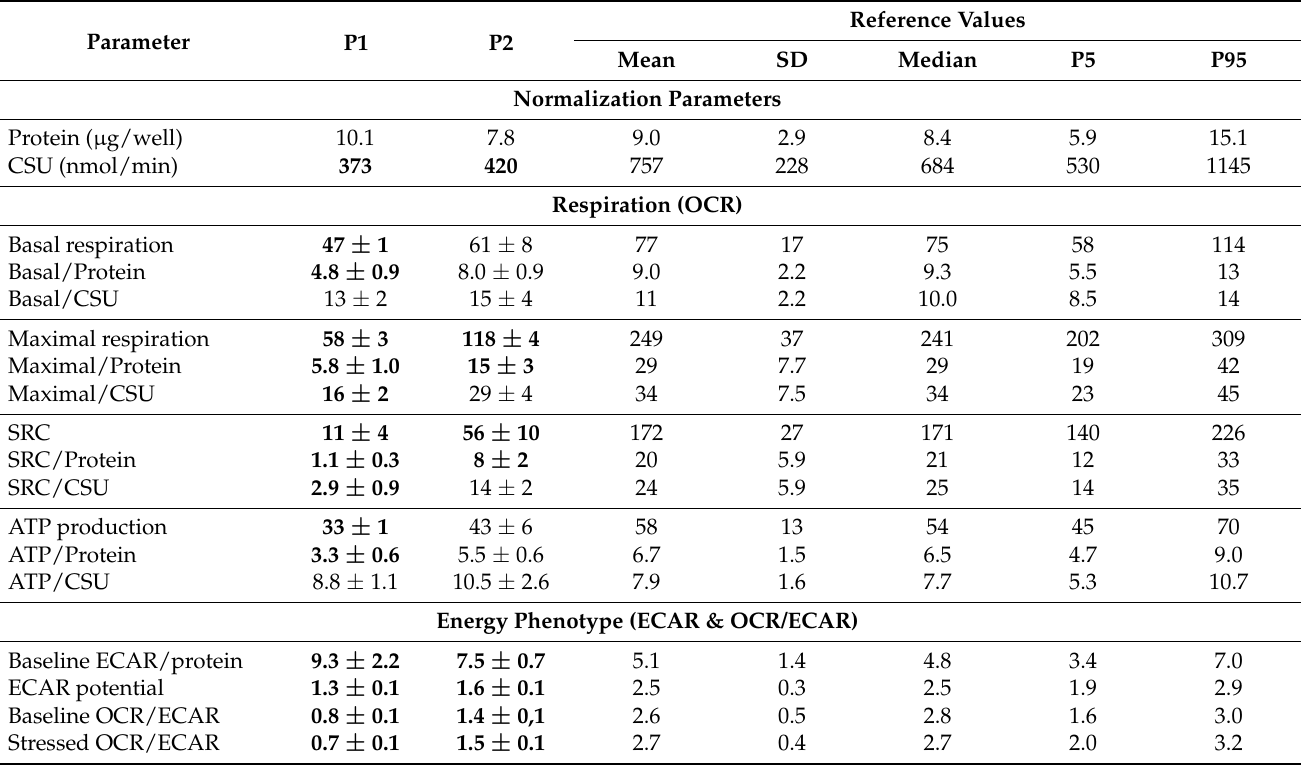
Table 2. Results of the bioenergetic measurements.